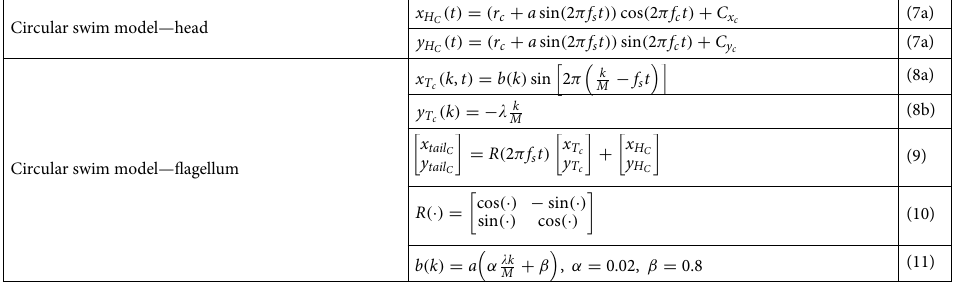
, y Table 1. Simulation of a circular swimming cell. ( x H H C ) : head position of circular swimming cell. r c : C radius of the circular path. a : amplitude of the sinusoid modulated on the circular path. f s : frequency of the , C sinusoid modulated on the circular path (Hz). f c : frequency of the circular cycle (cycle/s). ( C x y c ) : vertical c , y and horizontal offset constant. ( x Tail Tail C ) : a set of k points along the center of the flagellum of circular C swimming cell. (cid:31) : wavelength of flagellum (distance between the start and the end of the flagellum). R ( · ) : rotation matrix. b ( · ) : local variation in beating amplitude along the flagellum.